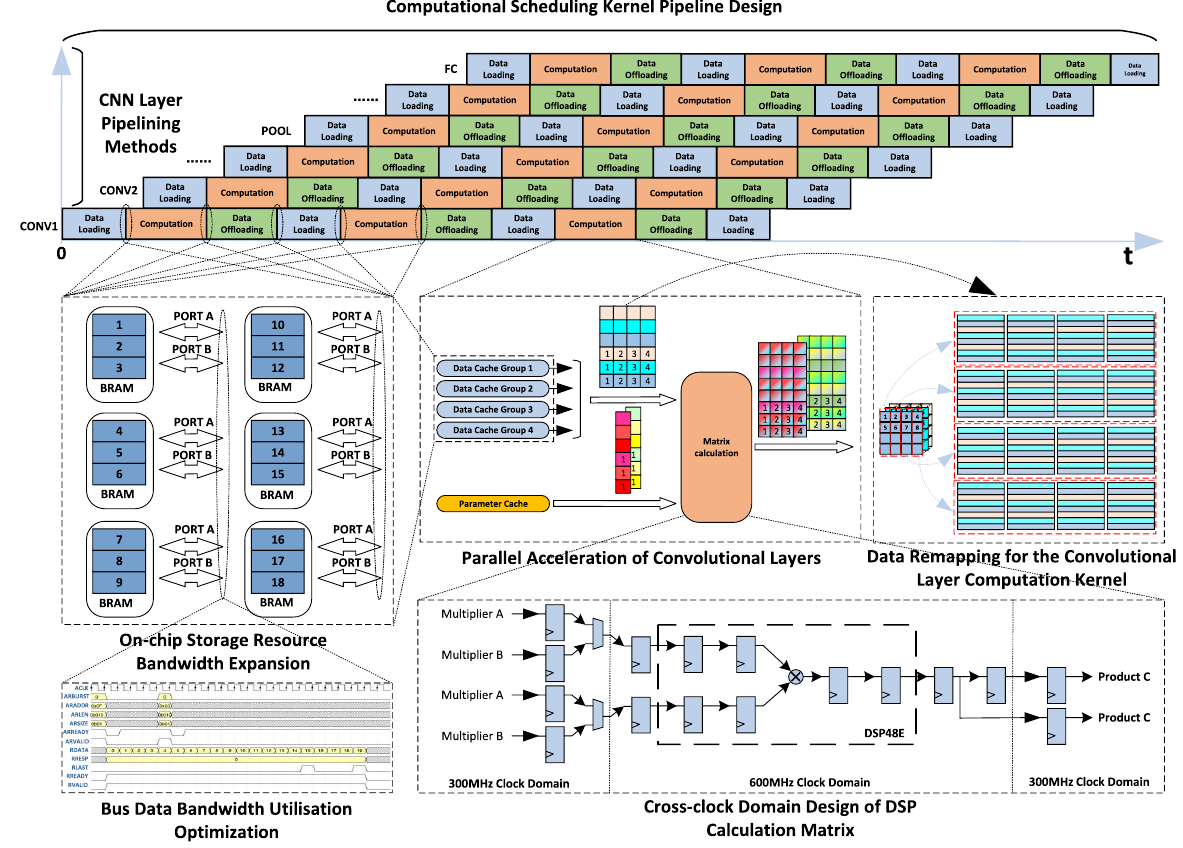
Figure 2. A full view of our proposed method.